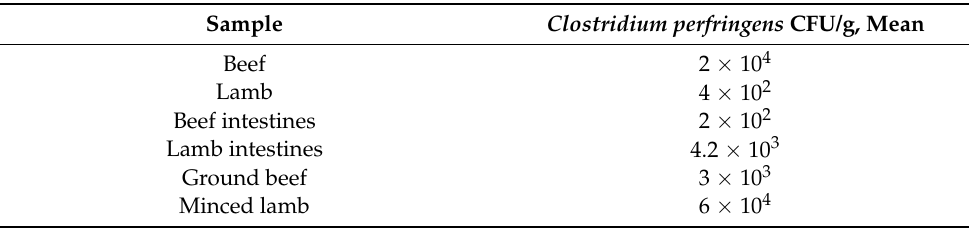
Table 3. The total number of vegetative Clostridium perfringens cells in meat products ( n = 240) collected from meat fairs ( n = 4) in West